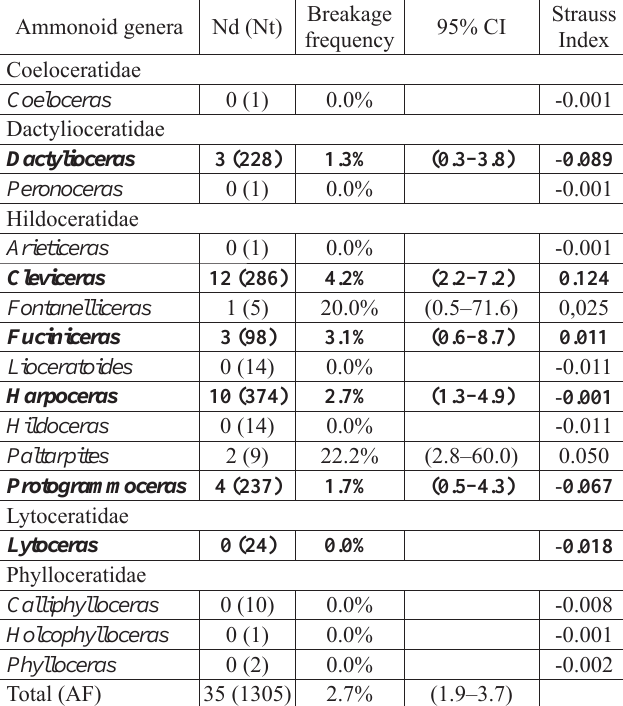
Table 1. List of early Toarcian ammonoid genera collected from the Nishinakayama Formation and breakage frequencies for the specimens of individual genera and total assemblage (AF). Nd, number of ventral- ly damaged specimens; Nt, number of total specimens; CI, confidence interval. Breakage frequency and Strauss Index for genera represented by more than 20 specimens are shown in bold.